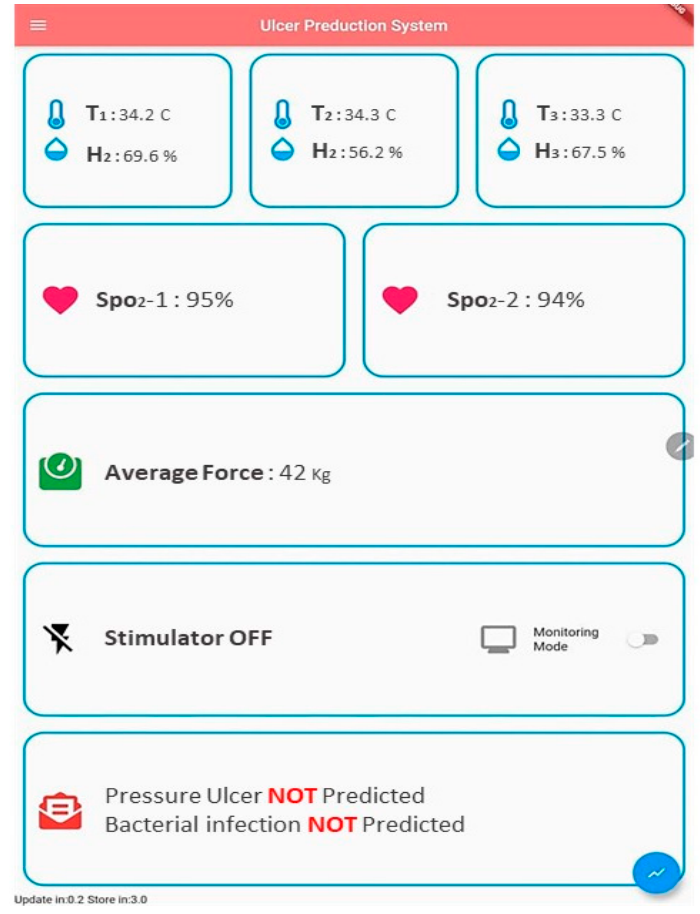
Figure 7. Application